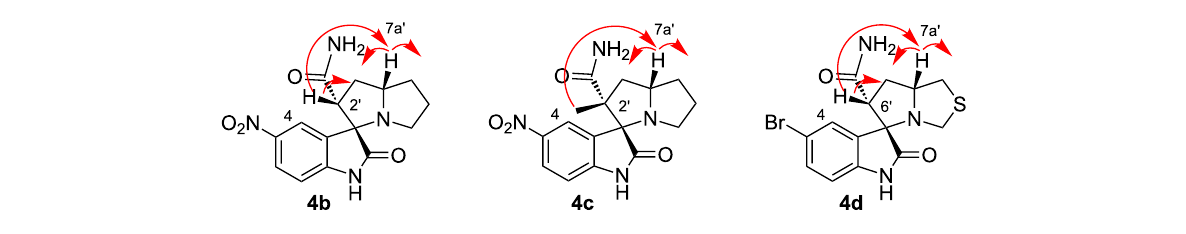
Figure 1: The NOE correlations of the signals in 1 H NMR spectra of compounds 4b–4d .